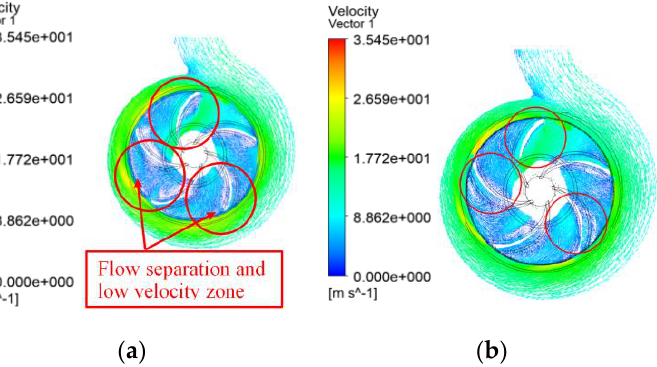
Figure 16. Velocity contours of flow region at 1500 rpm. ( a ) Original model; ( b ) rounded model.